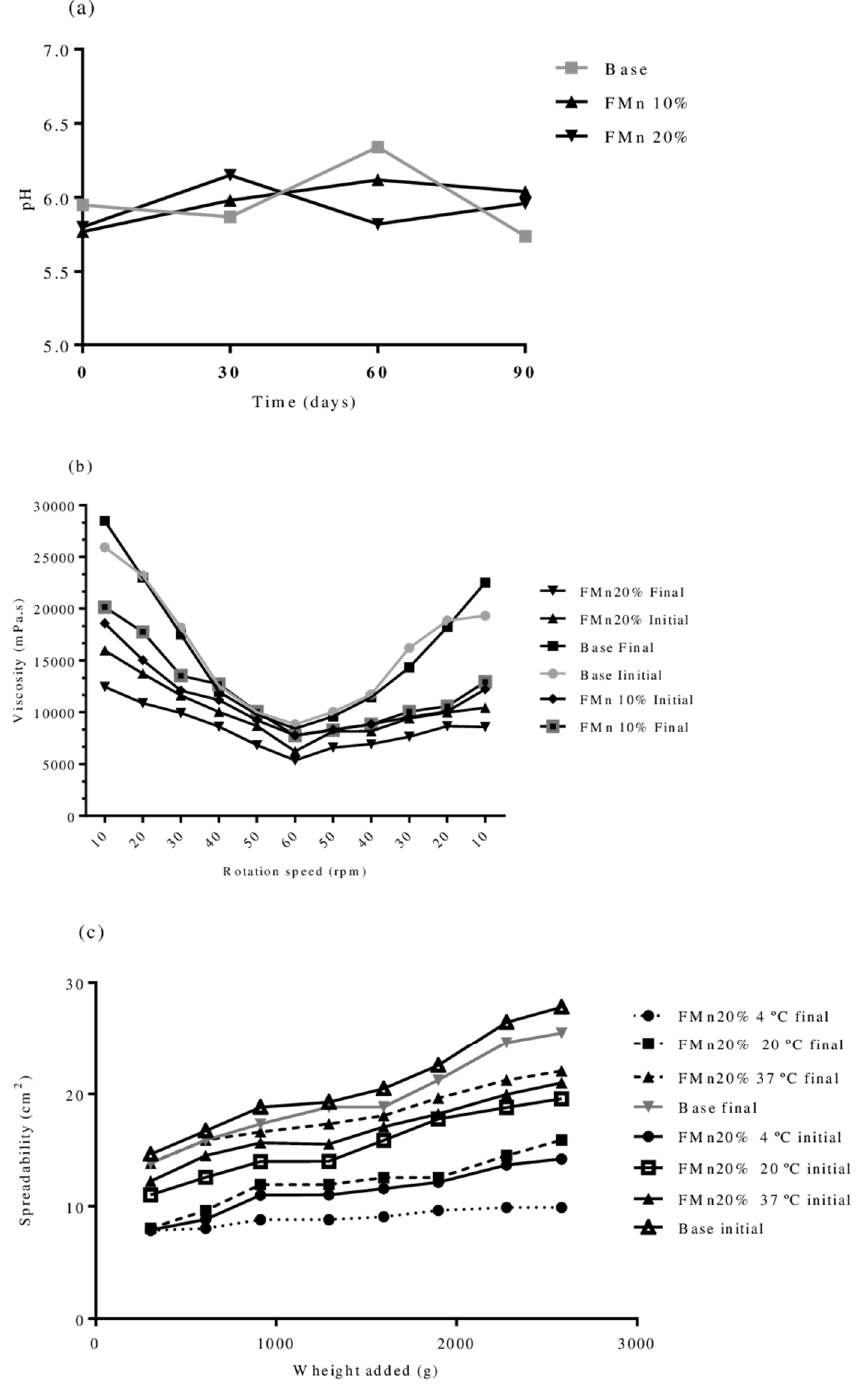
Figure 4. Mean values and standard deviations (Mean ± SD) (number of observations, n = 3) of pH ( a ), viscosity ( b ), and spreadability ( c ), in the base-emulsion and emulsions containing extract of Morus nigra .